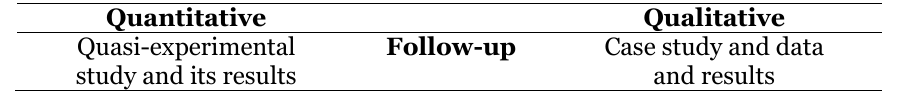
Explanatory Mixed Method Design